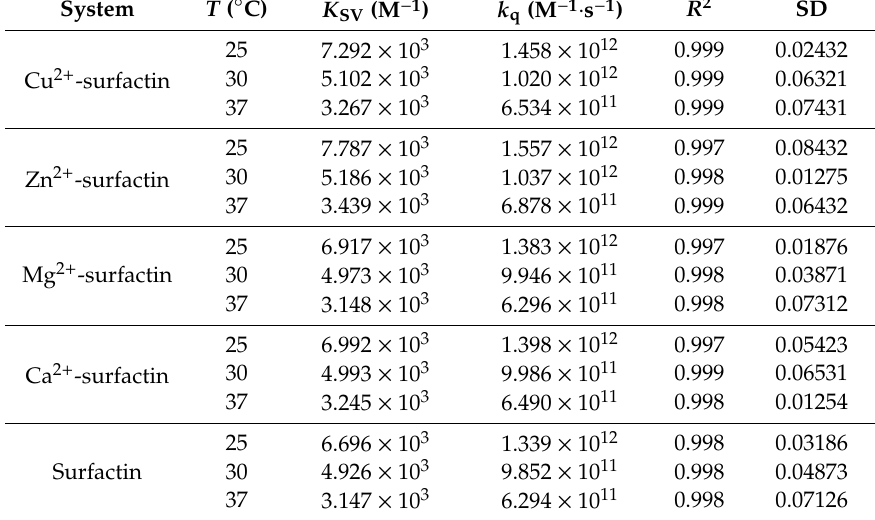
Figure 5. Stern–Volmer plots of the fluorescence titration of Cu 2+ -surfactin ( a ), Zn 2+ -surfactin ( b ), Mg 2+ -surfactin ( c ), Ca 2+ -surfactin ( d ) and surfactin ( e ) with BSA. Conditions: BSA: 15 µM; pH = 7.4; T = 25/30/37 °C. Table 2. Summary of Stern–Volmer data for BSA quenching by surfactin and metal-surfactin complexes.